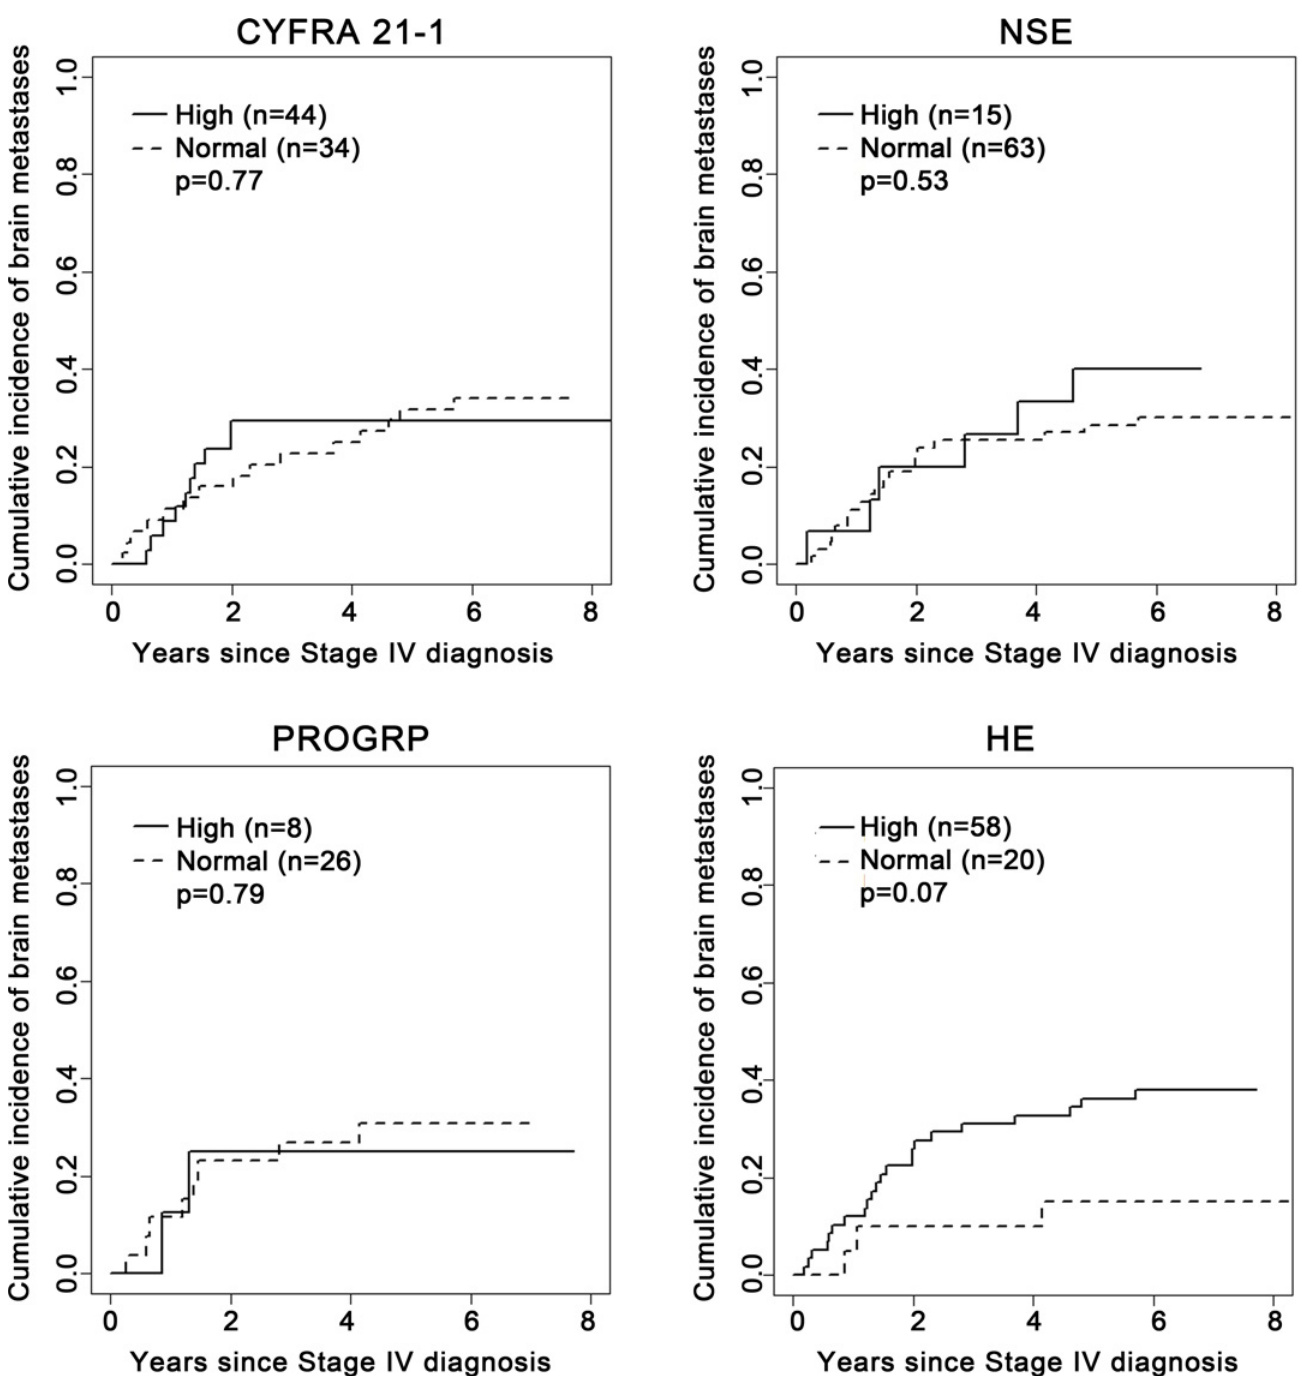
Fig 1. Association of serum biomarkers with cumulative incidence of subsequent brain metastasis in patients who did not experience brain metastasis at baseline. doi:10.1371/journal.pone.0146063.g001 PLOS ONE | DOI:10.1371/journal.pone.0146063 January 5,